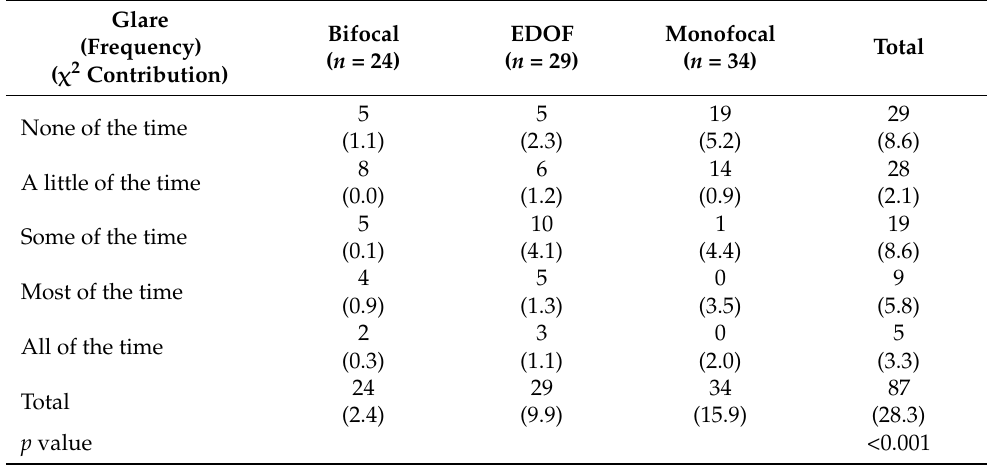
Table 6. Data obtained using the questionnaire subscales to evaluate the levels of postoperative optical quality in terms of glare and halos among groups.